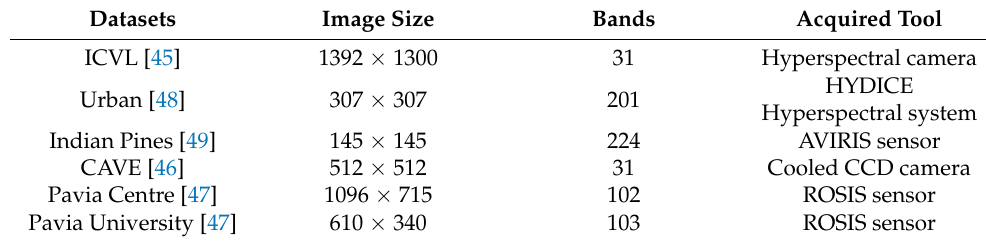
Table 1. The summary of the used datasets for HSI